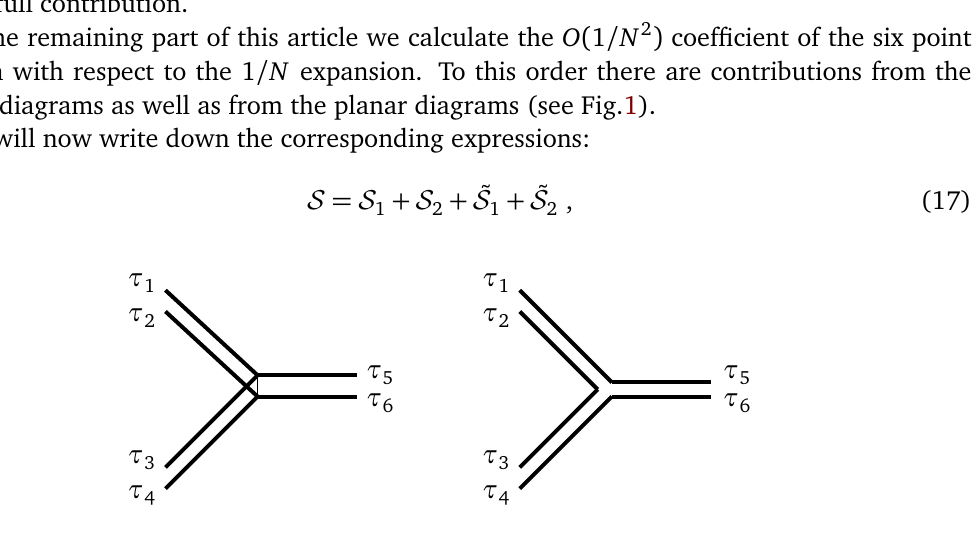
Figure 1: Contact (left) and Planar (right) diagrams for six point function. The dou- ble lines are dressed four point functions which include melonic